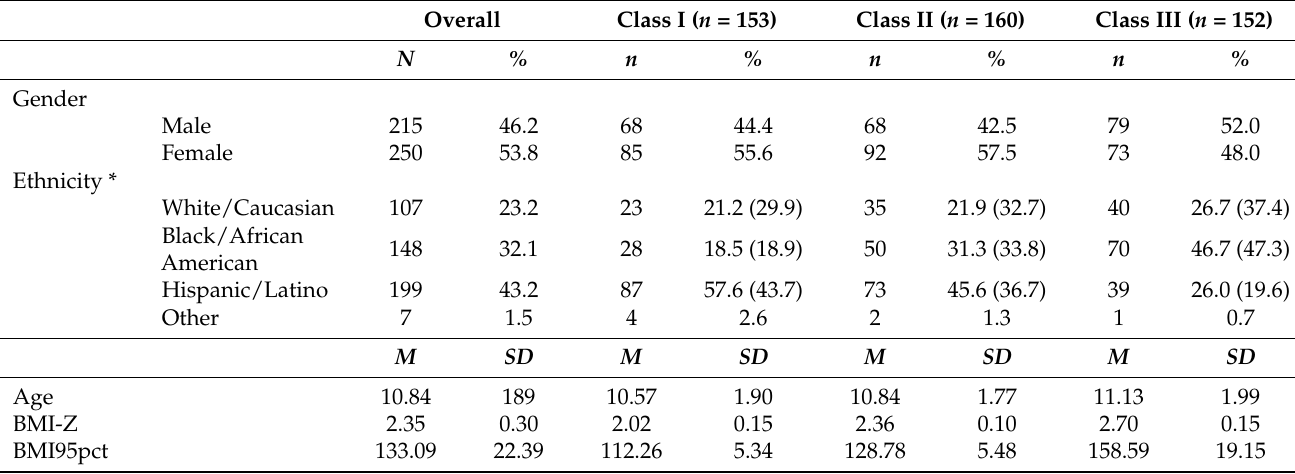
Table 1. Overall Demographics and Demographics by Obesity